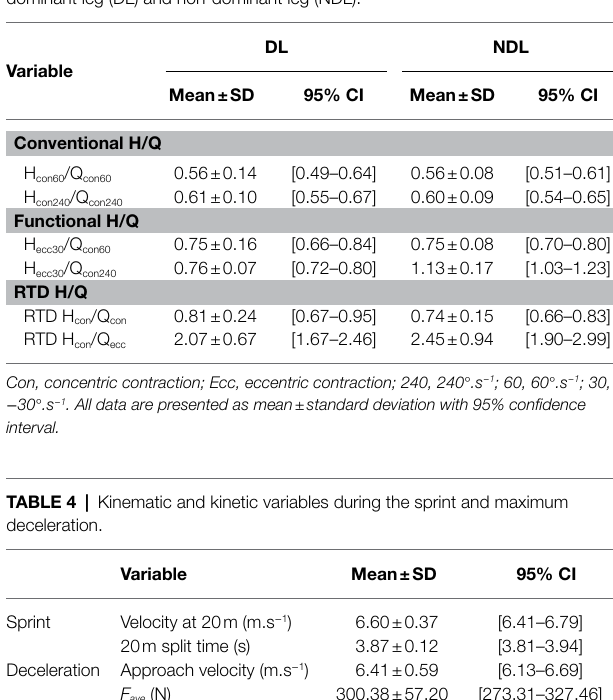
TABLE 3 | Traditional H/Q ratio (H/Q) and KF RTD to KE RTD ratio (RTD H/Q) in dominant leg (DL) and non-dominant leg (NDL). DL NDL Variable